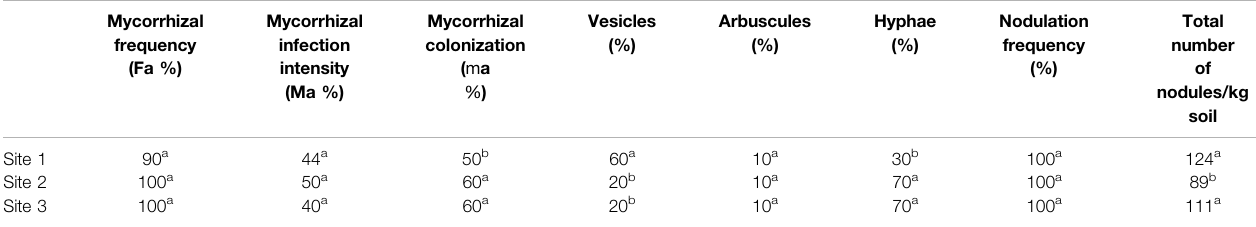
TABLE 2 | Mycorrhizal and nodulation traits in roots of Acacia cyanophylla collected in different sites in the sand dune ecosystem of Essaouira. Mycorrhizal